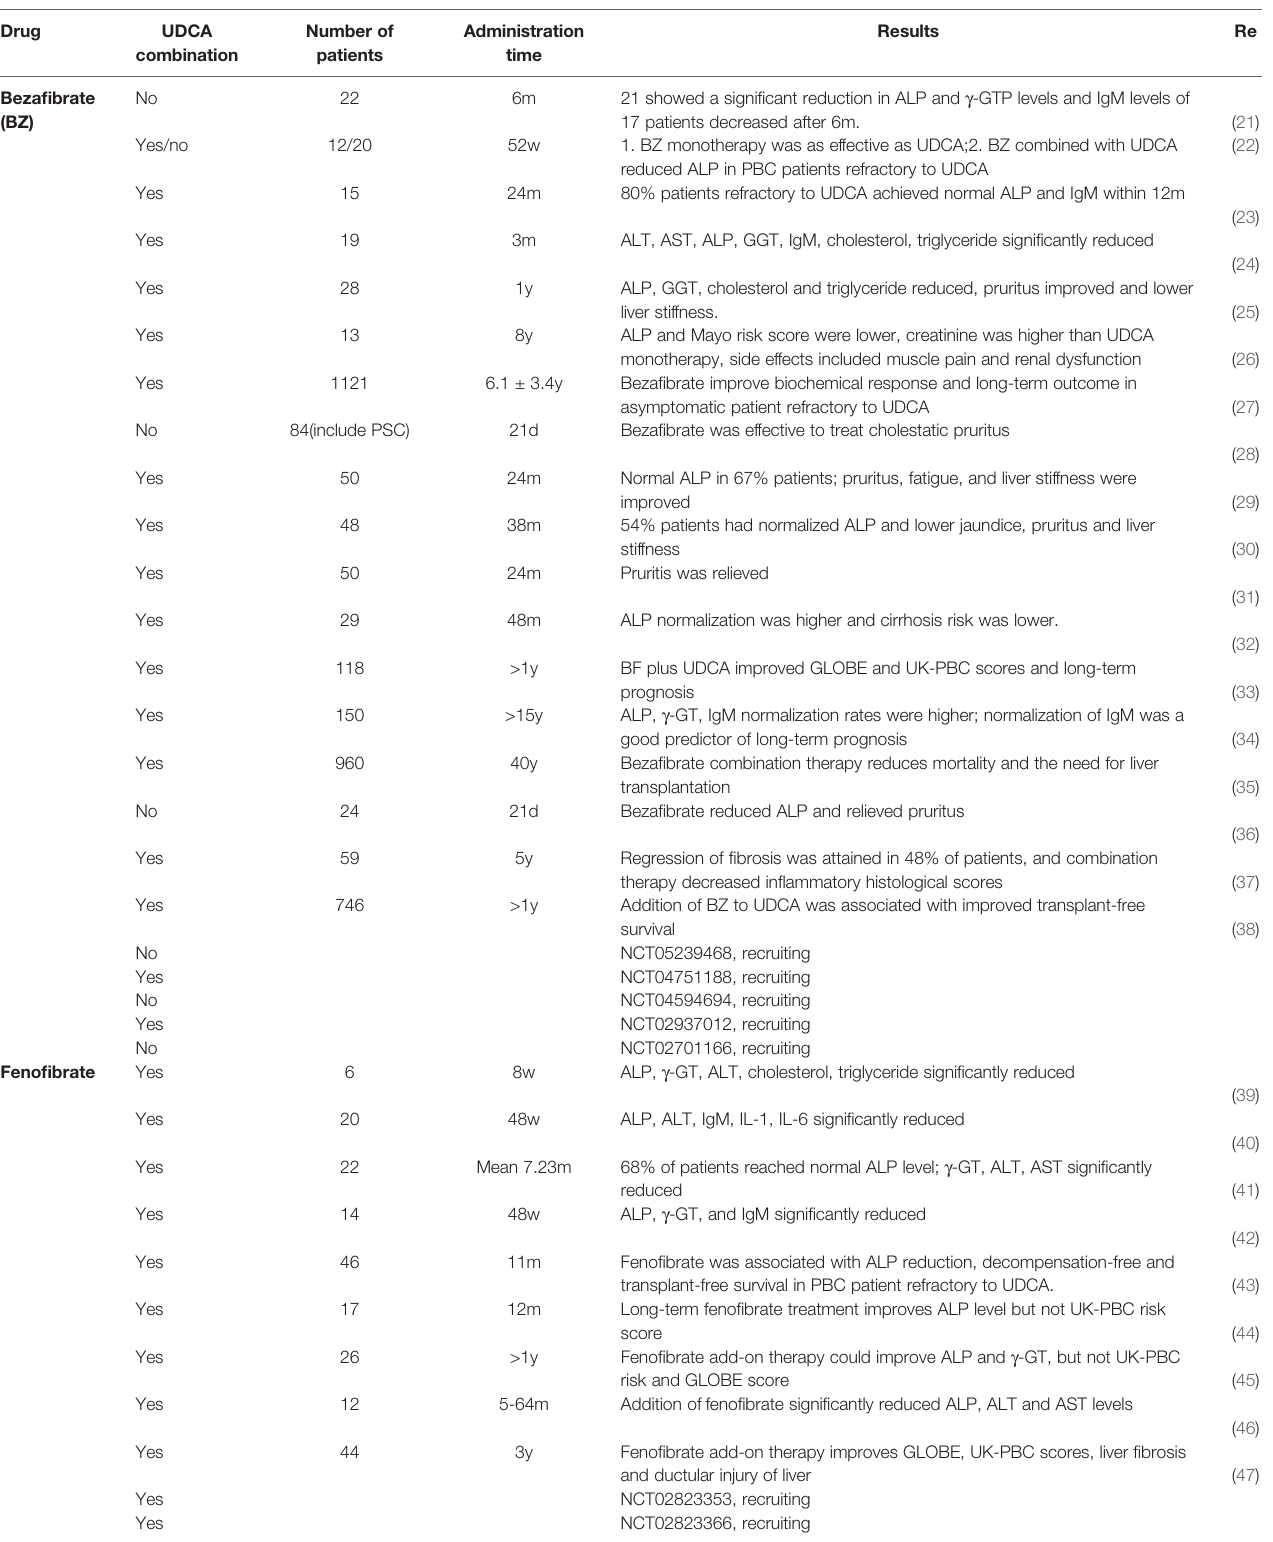
TABLE 1 | clinical studies of PPAR agonists on the treatment of PBC.